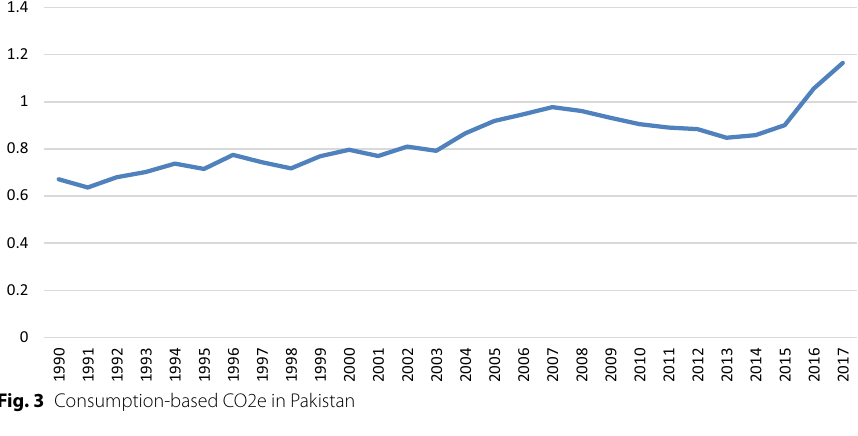
Fig. 3 Consumption-based CO2e in Pakistan